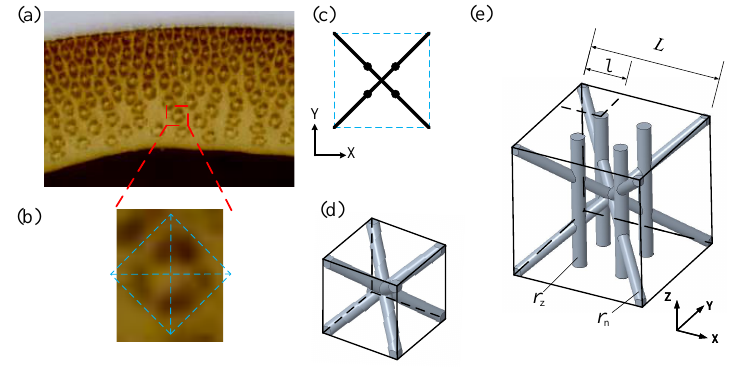
Figure 1. The bamboo-inspired design of lattice cell configuration as BCC4IZ ( a ) Bamboo section (photo is taken by the first author) ( b ) Vascular bundle of bamboo ( c ) Bionic 2D Section ( d ) BCC lattice ( e ), and BCC4IZ lattice.